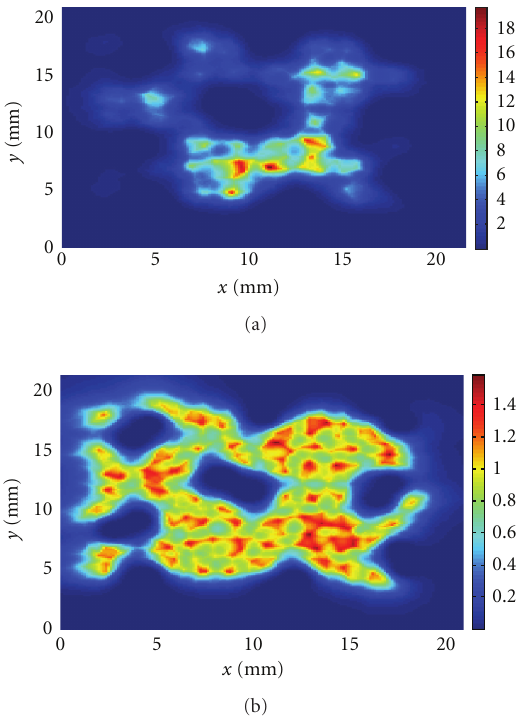
Figure 10: Total thermal dose accumulation in the midplane for the sequential insonation treatment (a) with fixed power and (b) with variable power.